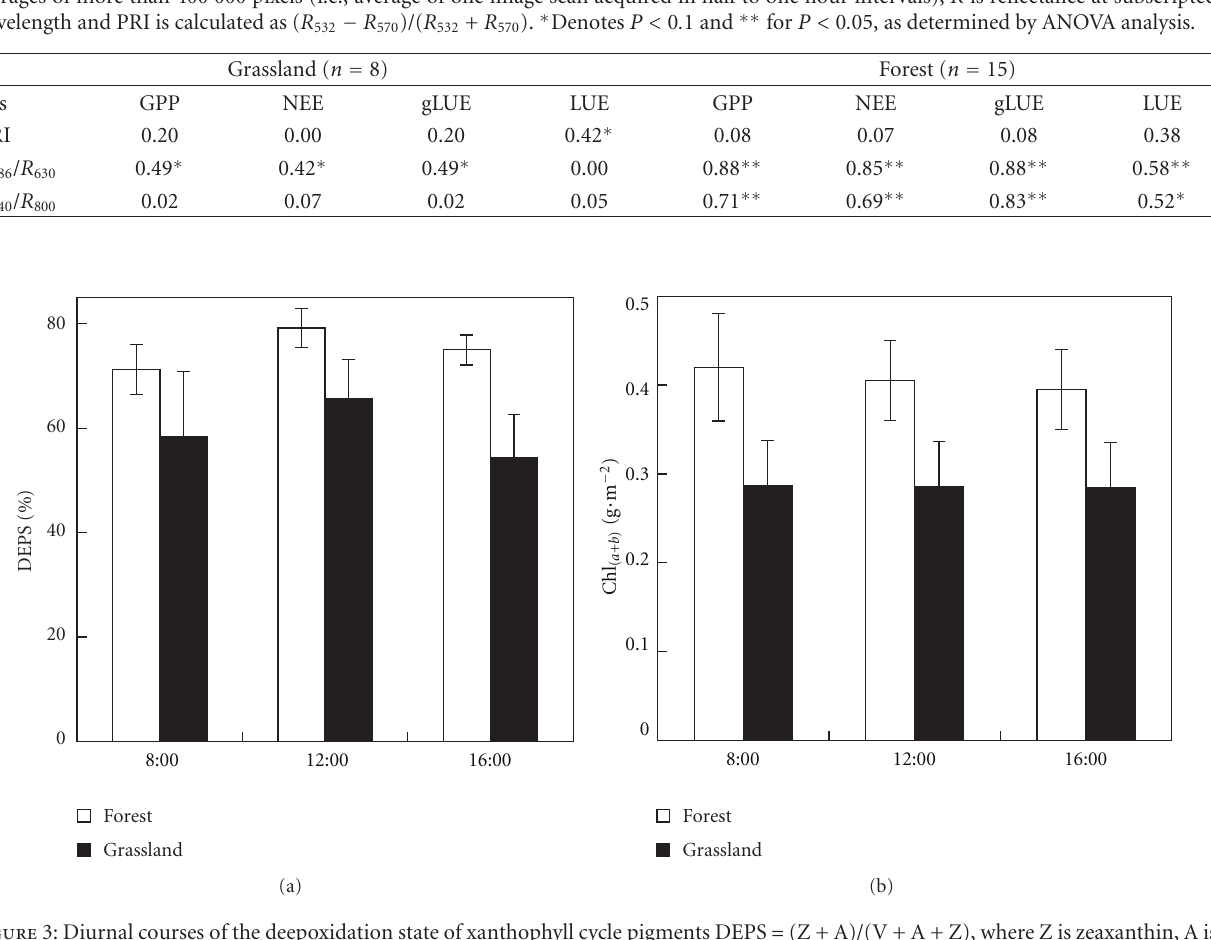
Table 2: Summary of coe ffi cients of determination ( R 2 ) found for the best-fit between vegetation indices (VIs) and physiological parameters derived from eddy-covariance measurements in grassland and forest ecosystems. Gross primary production (GPP [ μ mol (CO 2 ) m − 2 s − 1 ] =